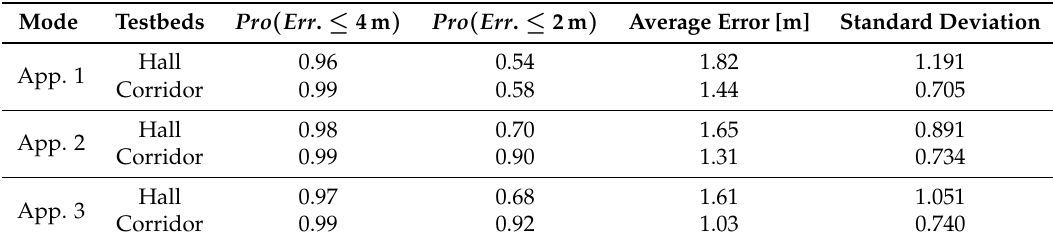
Table 4. Positioning accuracy of the proposed IPS for each application.